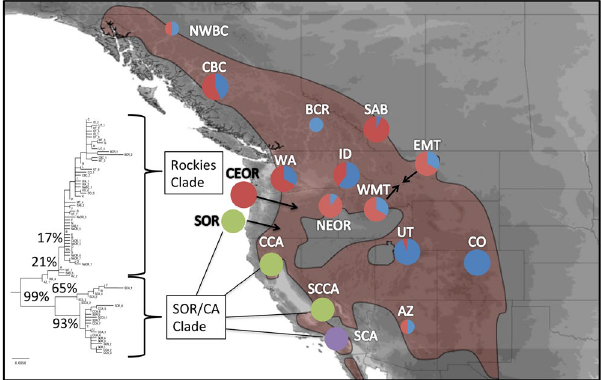
Figure 3. Unrooted ML tree with bootstrap values (left) and BAPS 95% CI cluster assignment (K = 4) of mtDNA. Contemporary mountain chickadee distribution is outlined in main map, populations with small circles representing sites where < 5 individuals were sequenced, and larger circles where ≥ 5 individuals were sequenced. Colours represent the proportion of individuals that were assigned to each clade based on BAPS analysis. Green and purple circles represent individuals from the western clade (as outlined in Fig. 1), while blue and red represent haplotypes from the eastern clade. Range maps were created in DIVA-GIS 7.5 (www.diva-gis. org) using digital distribution files provided by Ridgley et al . 70